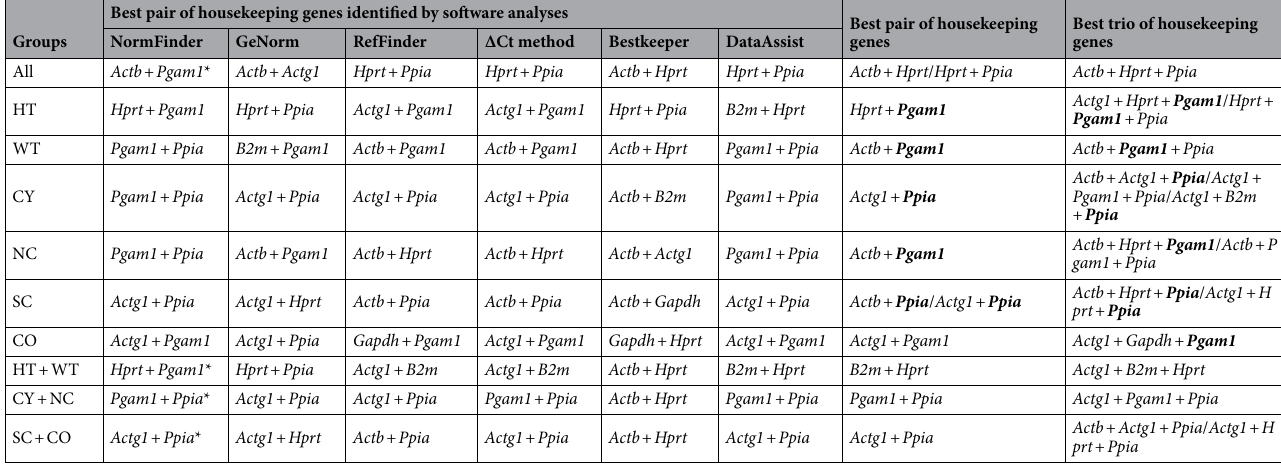
Table 2. Best combination of housekeeping genes for each group of samples, each model and respective control, and all groups yielded by software analyses. *Best reference genes considering intra- and intergroup variations. All, all samples; HT, haploinsufficient; WT, wild type; CY, cystic; NC, noncystic; SC, severely cystic phenotype; CO, control for the severely cystic phenotype. NormFinder (version 0.953; https:// moma. dk/ normf inder- softw are), GeNorm (version 2.2; https:// genorm. cmgg. be/), BestKeeper (version 1.0; https:// www. gene- quant ifica tion. de/ bestk eeper. html), DataAssist (version 3.01; https:// www. therm ofish er. com/ br/ en/ home/ techn ical- resou rces/ softw are- downl oads/ dataa ssist- softw are. html), the comparative ΔCt method and RefFinder (https:// www. heart cure. com. au/ reffi nder/). Genes in bold: higher frequency of appearance in softwares.